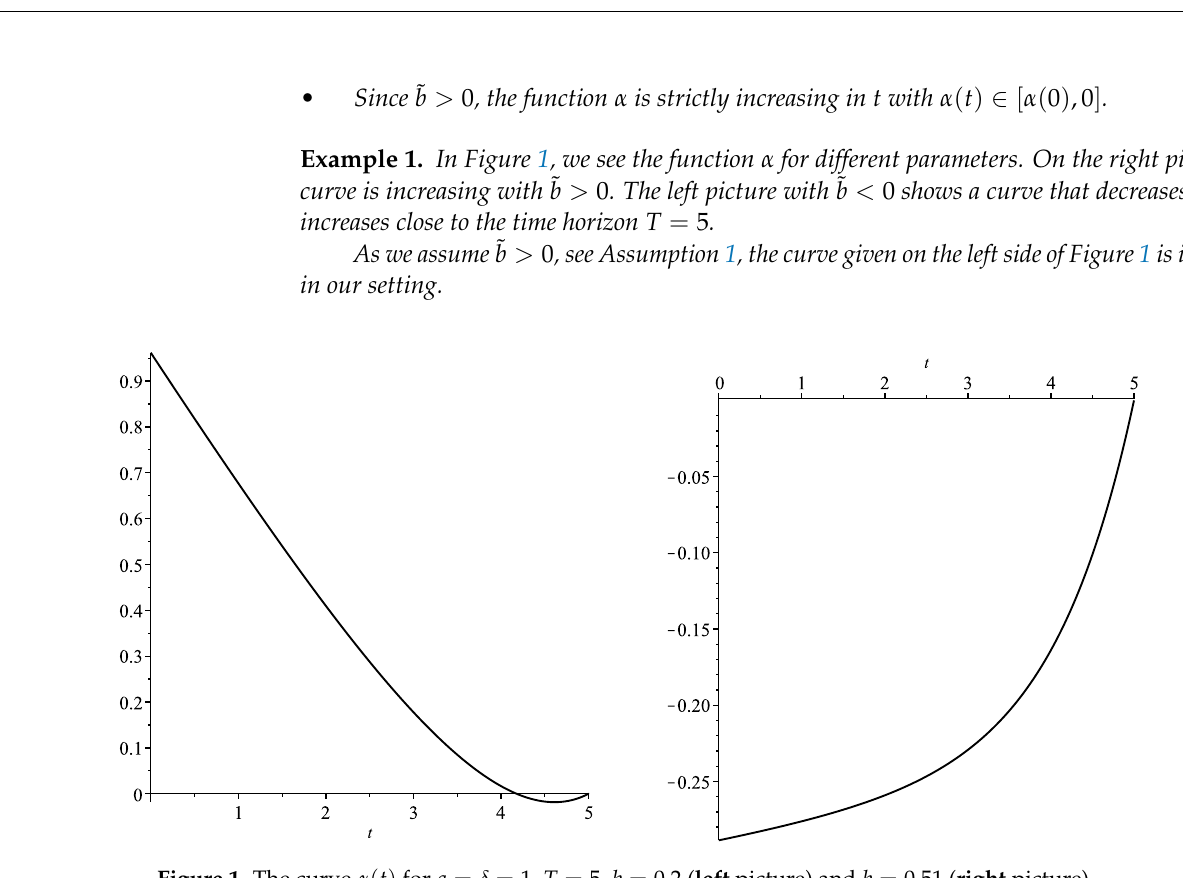
Figure 1. The curve α ( t ) for a = δ = 1, T = 5, b = 0.2 ( left picture) and b = 0.51 ( right